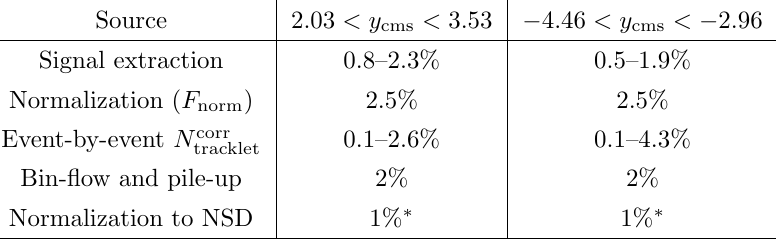
Table 2 . Sources of systematic uncertainties on the normalized yield. The contributions marked with an asterisk are correlated in multiplicity.